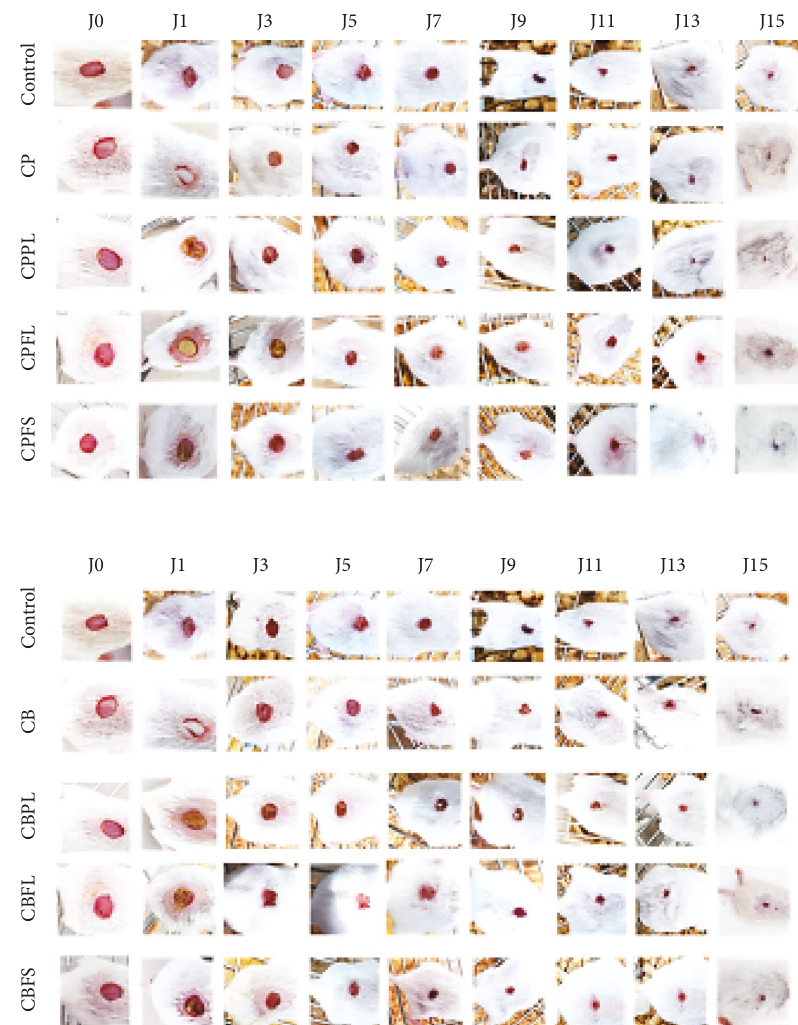
Figure 9: Photographic images showing the healing evolution of excisional wounds. PL: P. lentiscus leaf extract; FL: C. officinalis leaf extract; FS: C. officinalis flower extract; CP: fish collagen; CB: bovine